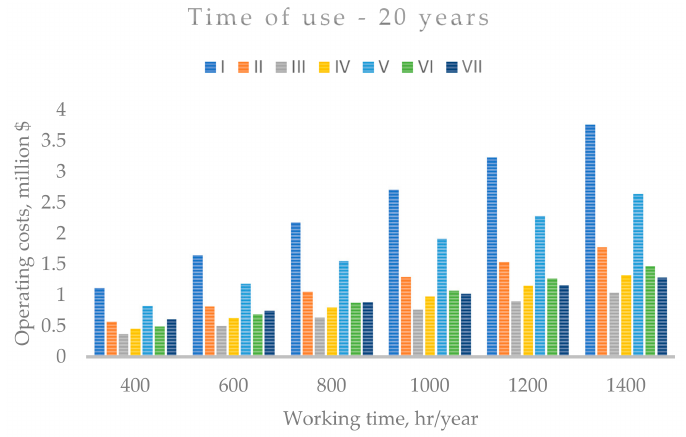
Figure 3. Chart of the operating costs of individual heating systems for an operating time of 400